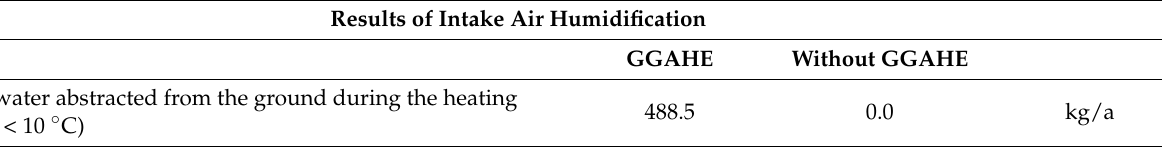
Table 3. Conditioning (humidifying and dehumidifying) the supply air to the